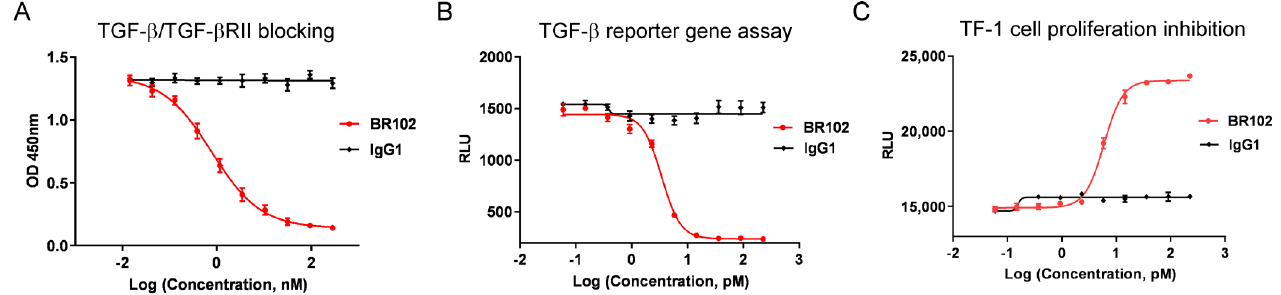
Figure 4. The inhibition effect of BR102 on TGF- β signaling pathway. ( A ) BR102 blocked the interaction of TGF- β 1 with TGF- β RII. ( B ) BR102 inhibited TGF- β 1-induced SMAD signaling in a β/SMAD luciferase reporter gene assay. ( C ) BR102 reversed TGF- β1 induced proliferation inhi bition TGF- β /SMAD luciferase reporter gene assay. ( C ) BR102 reversed TGF- β 1 induced proliferation of TF-1 cells. of TF-1 cells. inhibition of TF-1 cells.